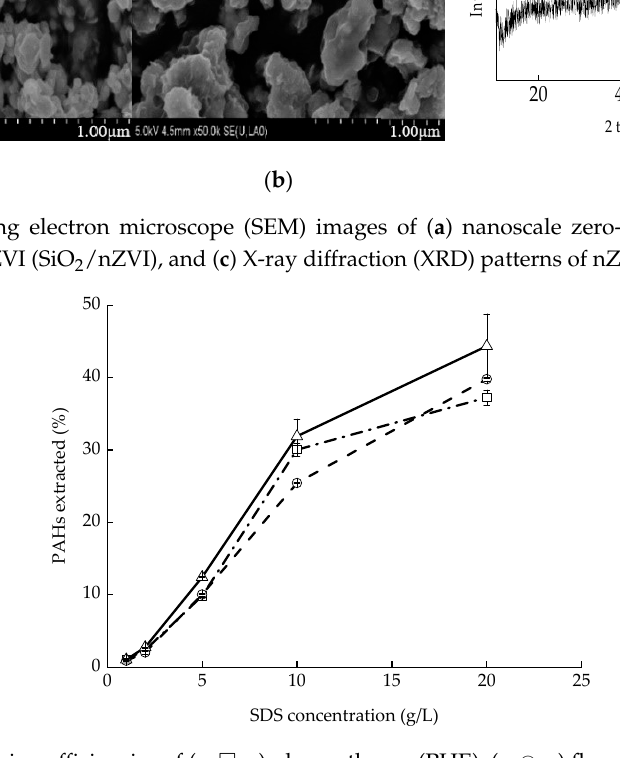
- -) fluoranthene (FLU), and (cid:35)